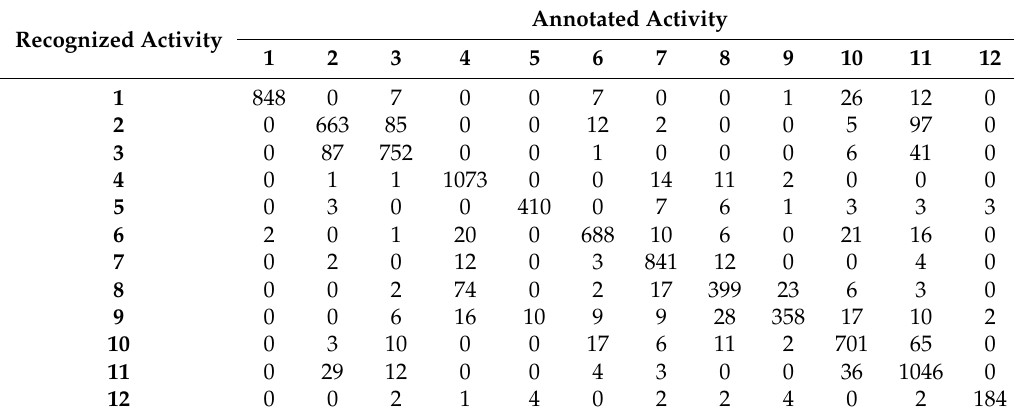
Table 5. Confusion matrix of testing data with three sensors using IE as feature.